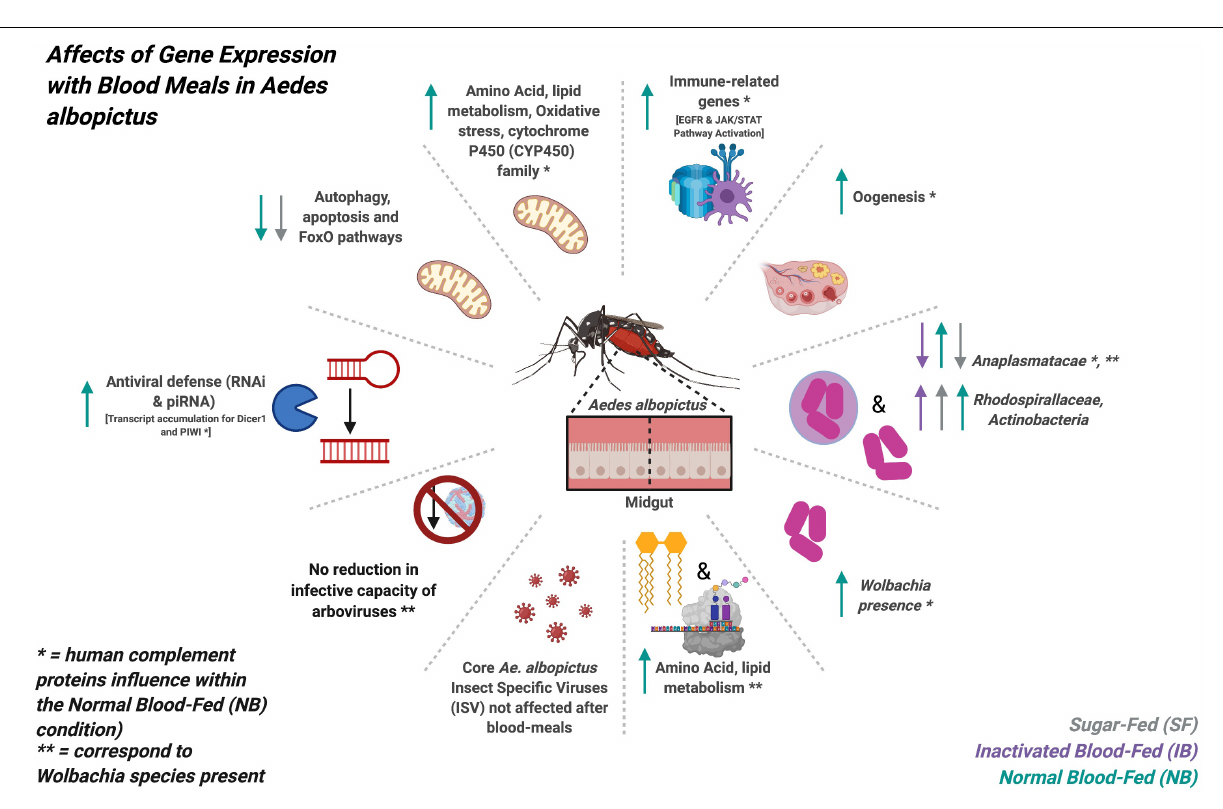
Frontiers in Microbiology |